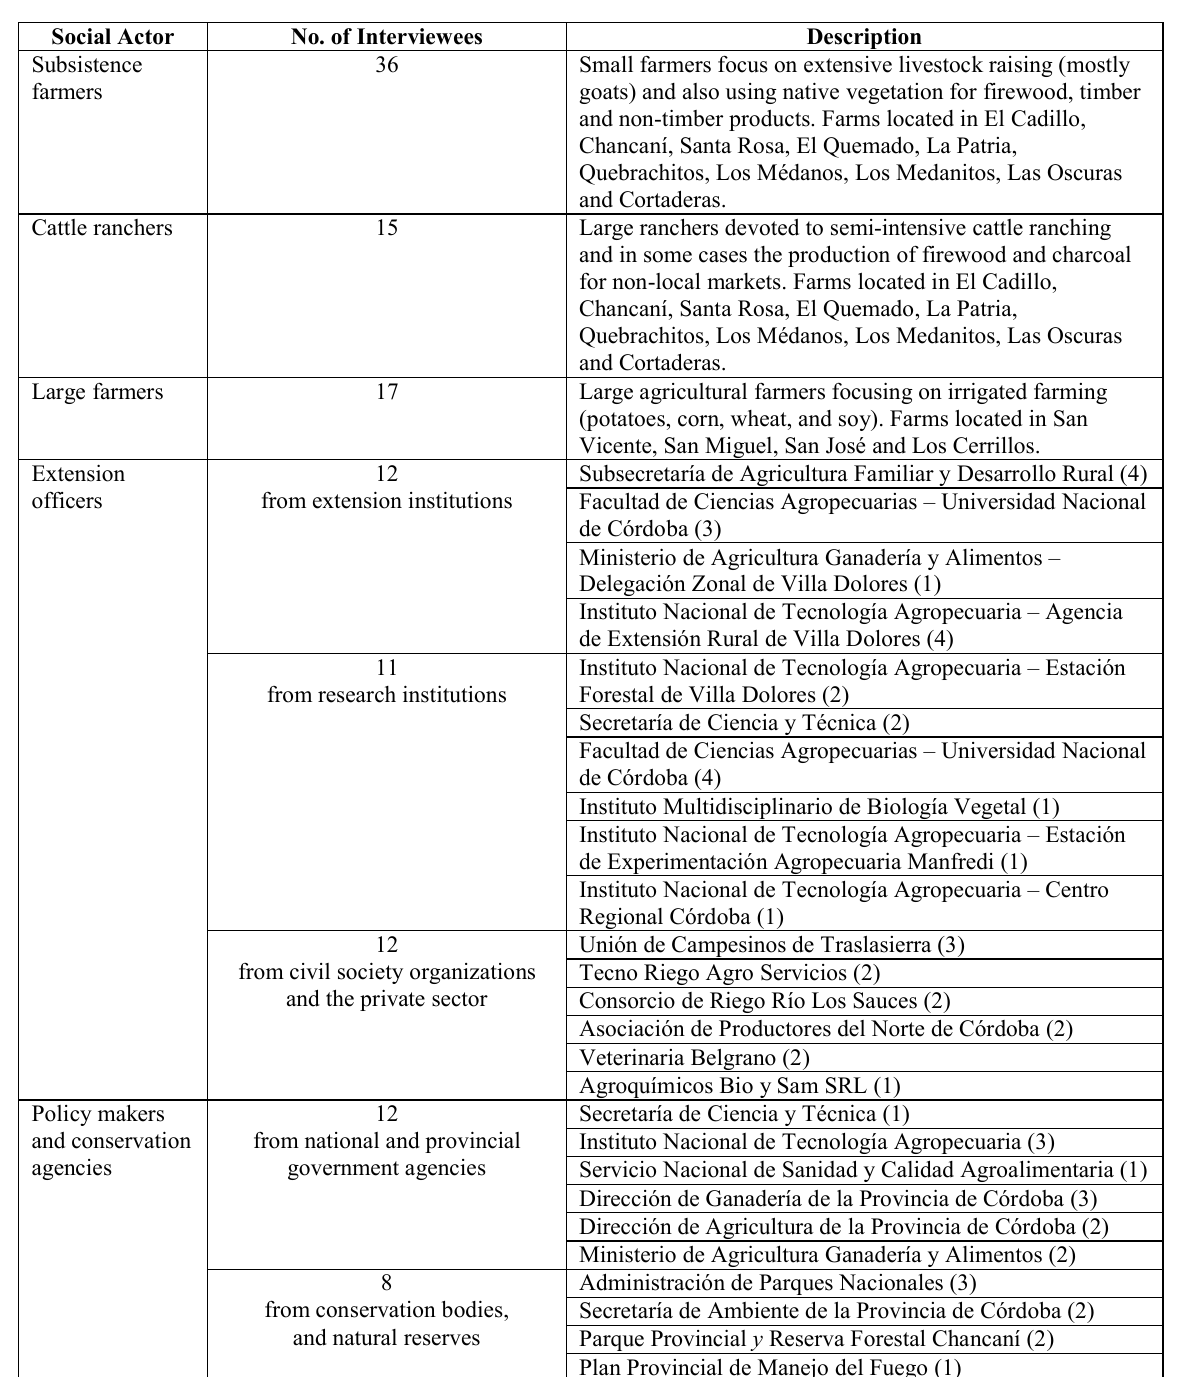
Table 1: Summary of the social actors (SA) interviewed in the study. The number between brackets represents the number of interviewees per institution. SA in the “Other” category were interviewed but did not participate as such in the focus